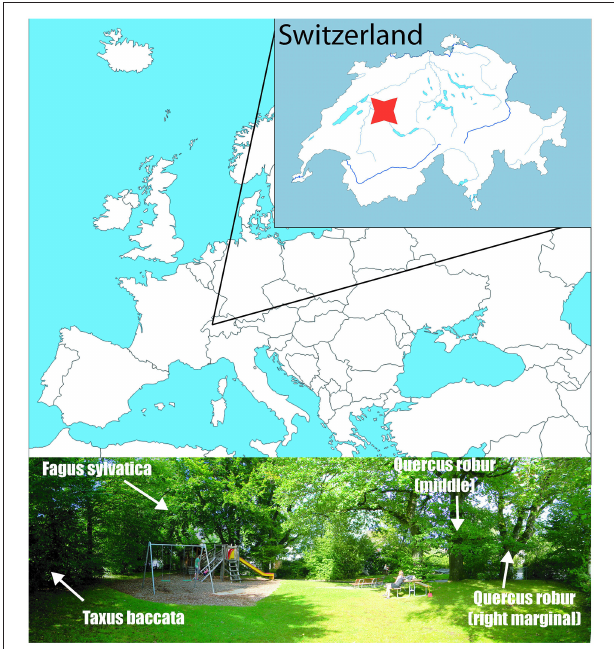
FIGURE 1 | Sampling site in Bern, Switzerland, denoted by the red mark (46.9283 ◦ N, 7.4317 ◦ E). The bottom picture shows the position of the sampled